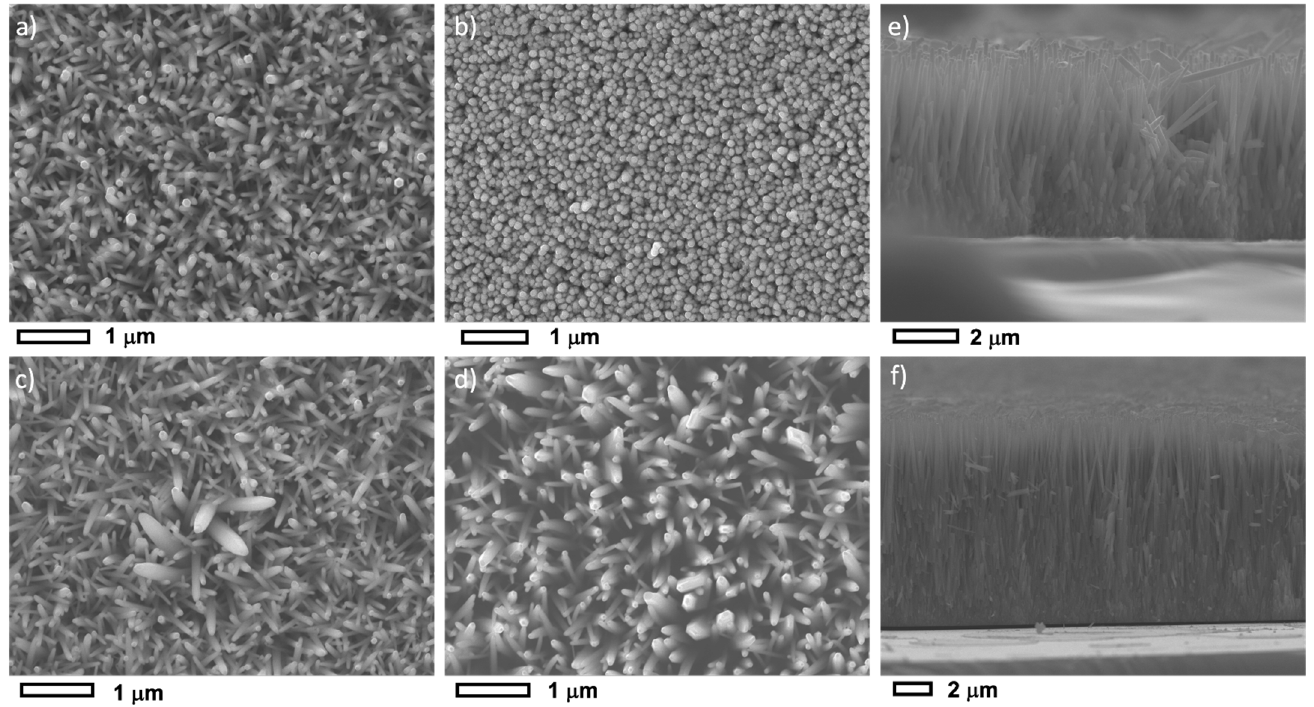
Figure 2. Top view FESEM images for ZnO NRs sample: ( a ) ZnO I, ( b ) ZnO II, ( c ) ZnO III, ( d ) ZnO IV. Top view FESEM images for ( e ) ZnO I, and ( f ) ZnO IV samples.